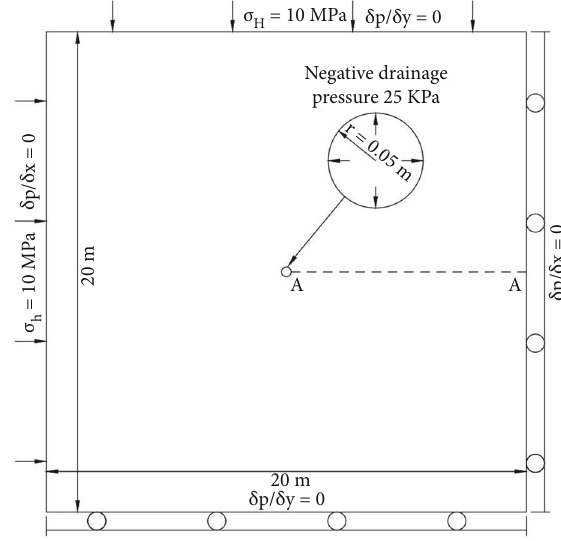
Figure 14: Schematic diagram for gas extraction